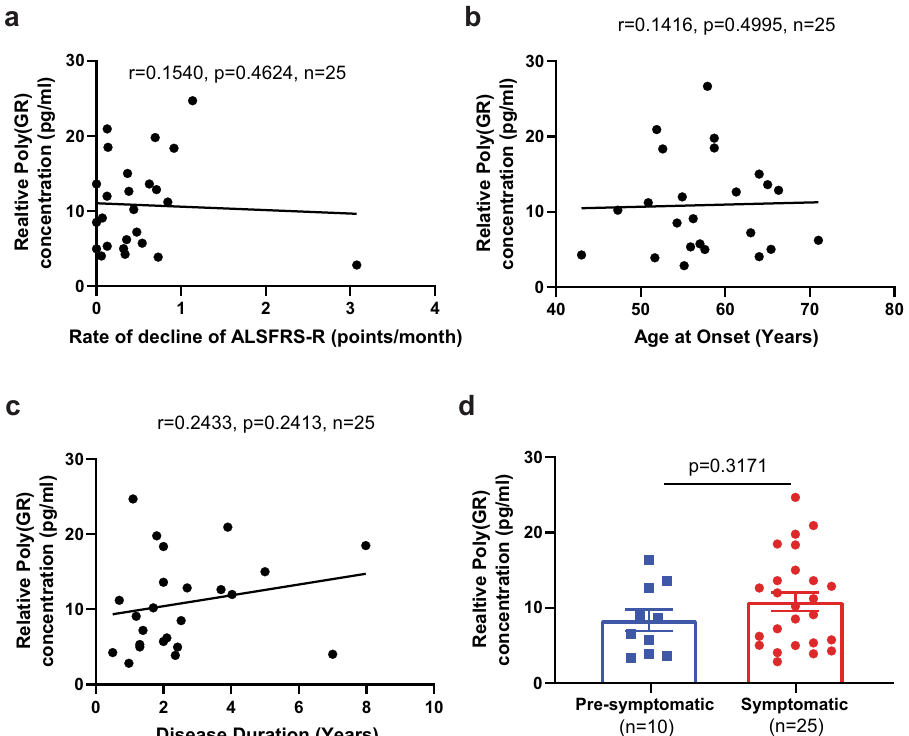
Fig. 2 Poly(GR) levels in CSF do not correlate with clinical features of patients with C9ORF72 mutations. a – c Correlations between poly(GR) levels and rate of ALSFRS-R score decline ( a ), age at disease onset ( b ), and disease duration ( c ), determined by two-tailed, Spearman ’ s rank-correlation analysis. d Poly(GR) levels in CSF of symptomatic and asymptomatic patients with C9ORF72 mutations are similar ( p = 0.114 by two-tailed unpaired t -test with Mann – Whitney test). Poly(GR) concentrations are presented as values equivalent to (GR) 8 peptide and not as an absolute poly(GR) concentration since the size of poly(GR) in CSF is unknown. 25 out of 41 symptomatic CSF samples and 10 out of 14 pre-symptomatic CSF samples had poly(GR) levels within the linear range of our standard curves and are presented here. ALS Functional Rating Scale revised (ALSFRS-R). Source data are provided as a Source Data fi